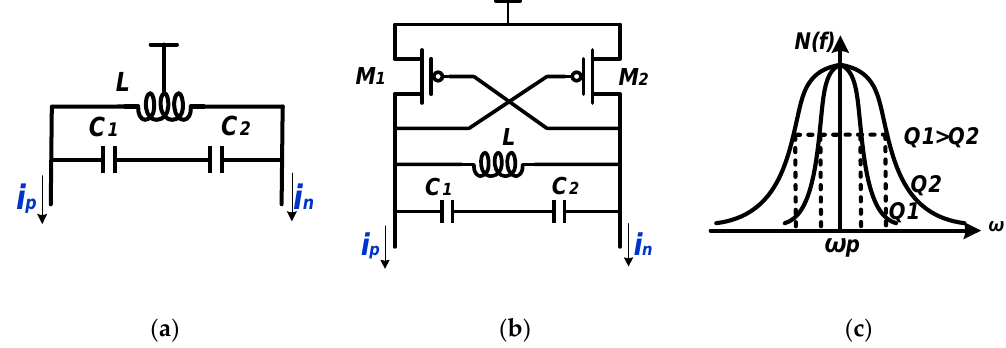
Figure 4. ( a ) The LC resonant load; ( b ) The Q-enhanced LC resonant load; ( c ) The tuning curve of the LC resonator.